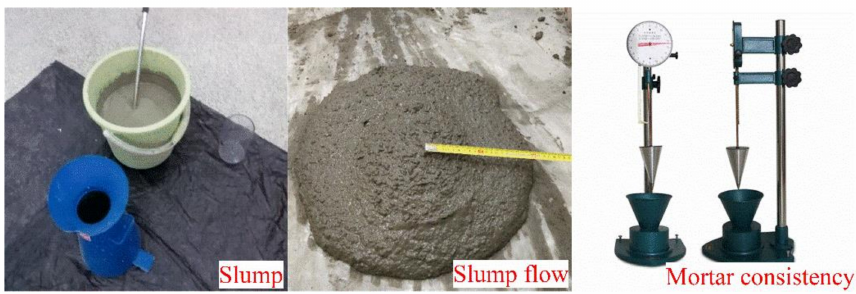
Figure 2. Slump and slump flow